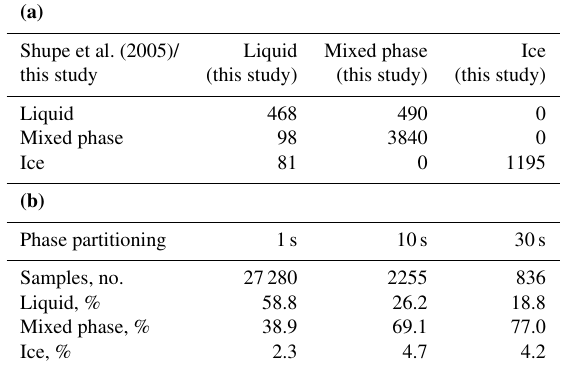
Table 3. (a) Comparison of cloud phase identifications between our classification method and the Shupe et al. (2005) method in 5min measurements each. The unit is number of 5min samples. Num- bers denote the cloud sample classifications between the two meth- ods. For example, the number 98 denotes that a total of 98 sam- ples are classified as mixed phase using the method in Shupe et al. (2005), while the rest are classified as liquid using this study’s method. (b) The cloud phase partitioning from the Cloud Droplet Probe (CDP) and the Two-Dimensional Stereo Probe (2DS) during SOCRATES. Note that the CDP measures particle sizes from 2 to 50µm in diameter, and the 2DS measures particle sizes from 50 to 5000µm in